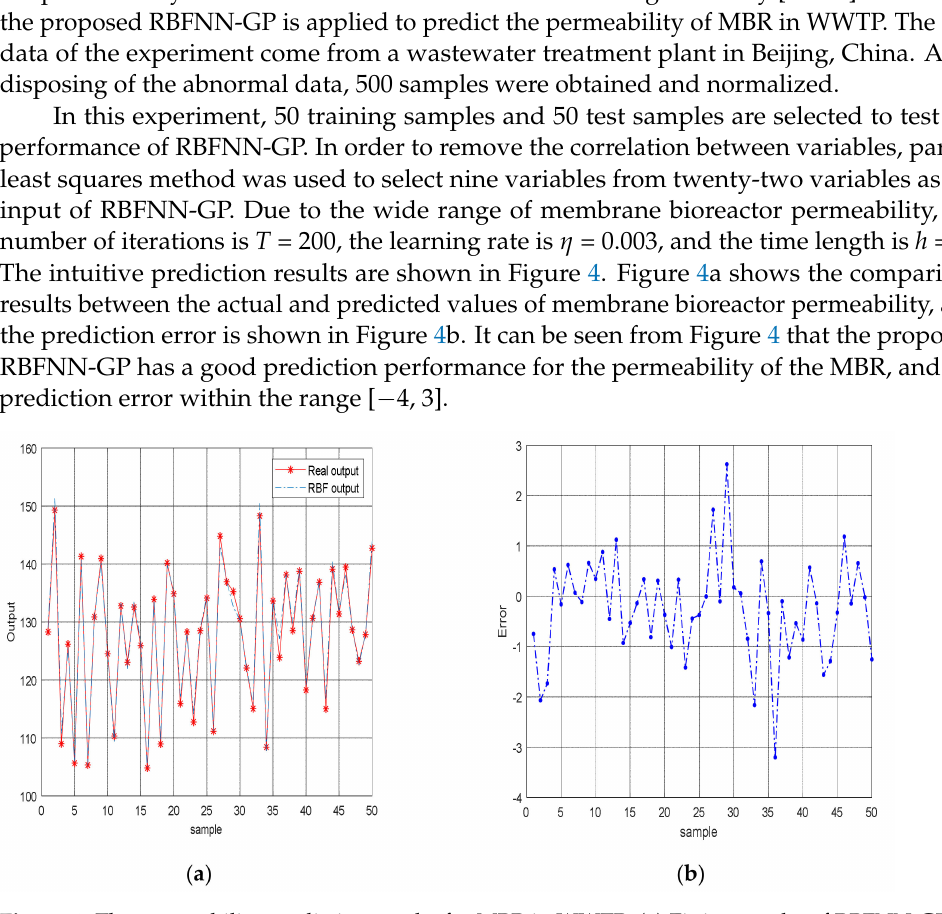
Figure 4. The permeability prediction results for MBR in WWTP: ( a ) Fitting results of RBFNN-GP for MBR; ( b ) Test output error for